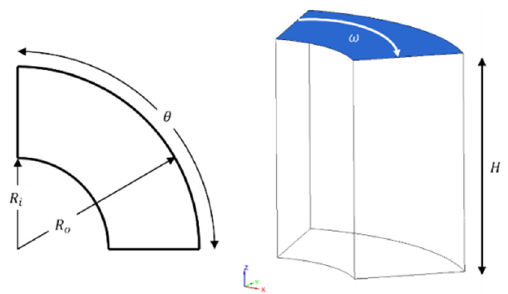
Figure 1. Schematic presentation of the mixture chamber.